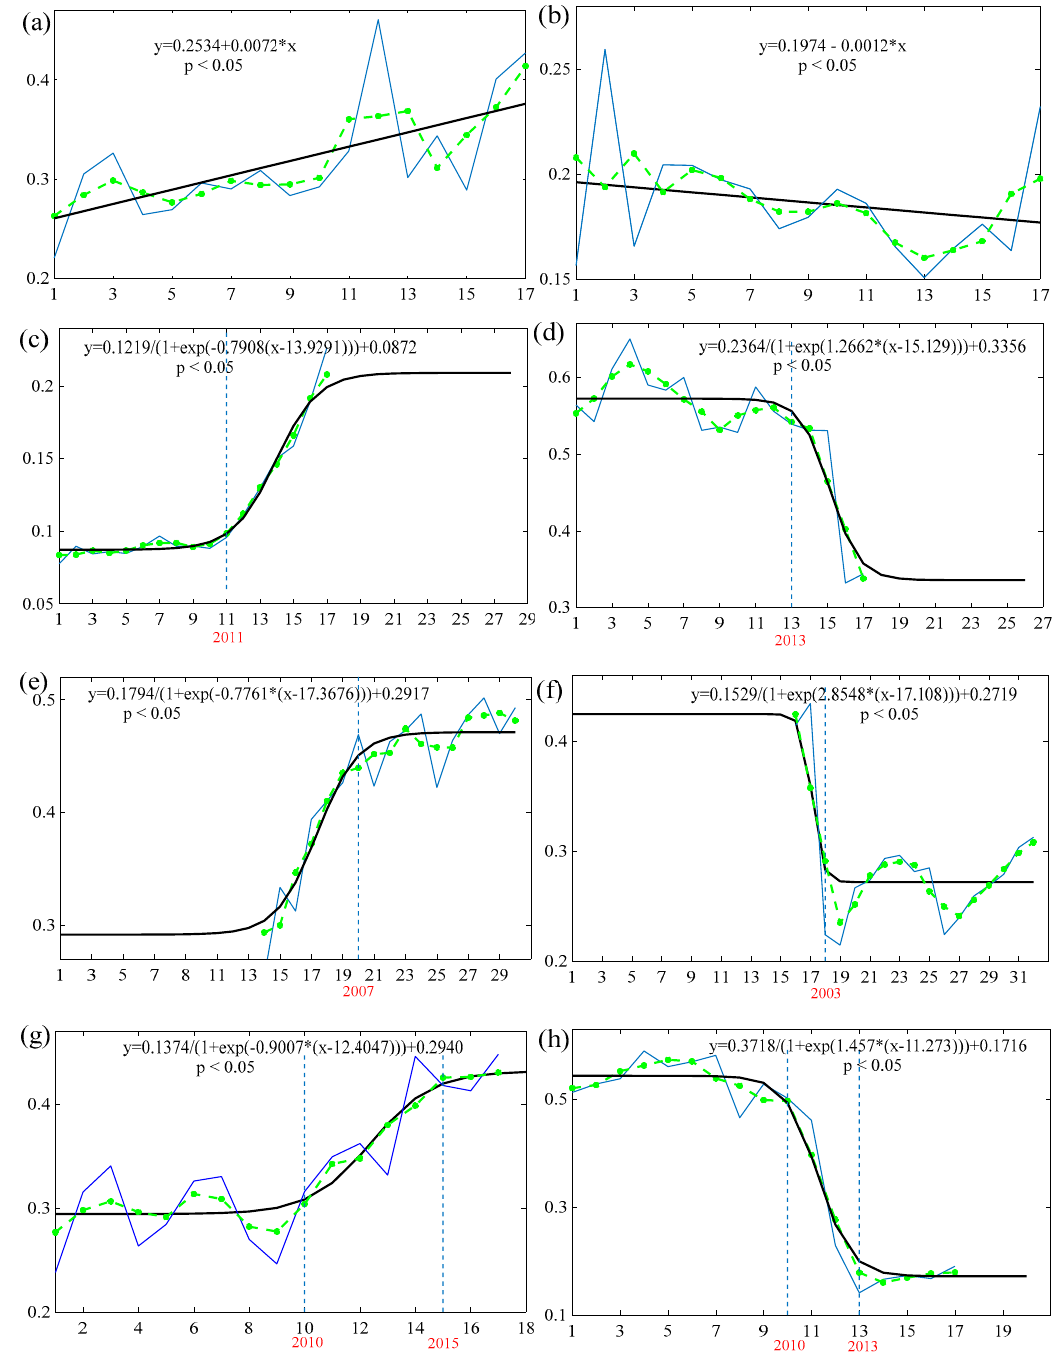
Figure 8. Processes of vegetation gradual changes in the eight reference sites ( a – h ) which are shown in Figure 3. The number of each subfigure corresponds to the number of reference sites in Figure 3, in which the pattern of each site detected by our framework is shown. The contents in each site include profiles of the original NDVI timeseries (blue solid line), the smoothed timeseries (green dotted line) and the fitting temporal profile (black line), the fitting function, and locations of the transition year (red word). Values in the horizontal axis in each subgraph represent the serial numbers in the prolonged timeseries (k) which ranges from 1 to L while that in the vertical axis are mean May to September NDVIs. The landscape transformation or modification for each site during the observation period are listed in Table 3.